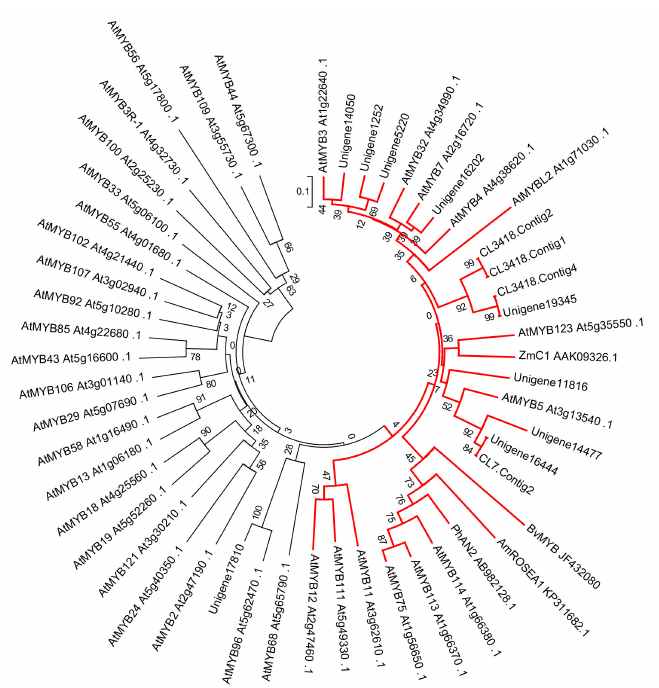
Figure 6. Maximum likelihood tree of MYBs in pitayas and R2R3 MYBs in Arabidopsis thaliana constructed by MEGA6 using the resources at IT3F (An Interspecies Transcription Factor Function Finder for Plants). Unigene11,816, CL7.contig2, Unigene16,444, Unigene14,477, CL3418.Contig1, CL3418.Contig2, CL3418.Contig4, Unigene19,345, Unigene16,202, Unigene15,050, Unigene5220, and Unigene1252 form a monophyletic clade with MYB transcriptors controlling anthocyanins and proanthocyanins biosynthesis, as depicted by red